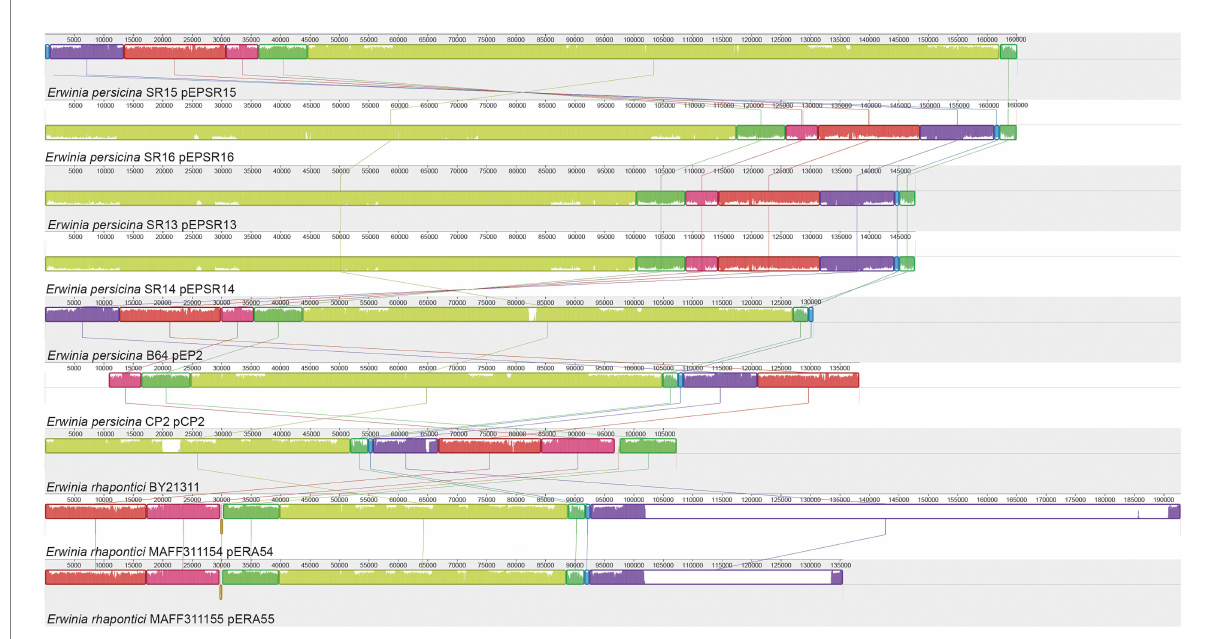
FIGURE 5 MAUVE alignment of Erwinia plasmids. Alignment of E. persicina and E. rhapontici plasmids. Plasmid sequences from E. persicina SR13, SR14, SR15, SR16, E. persicina B64 plasmid pEP2, E. persicina CP2, and E. rhapontici BY21311, MAFF311154 and MAFF311155 were aligned using the MAUVE software (Darling et al., 2010). Identically colored blocks denote homologous regions. Bar heights within blocks of homologous regions correlate with the level of conservation shared between the plasmid sequences. The numerical scale is in base